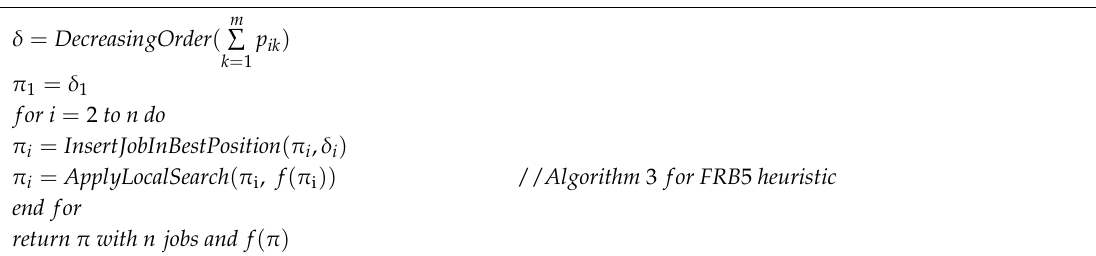
Algorithm 2: NEH and FRB5 constructive heuristics